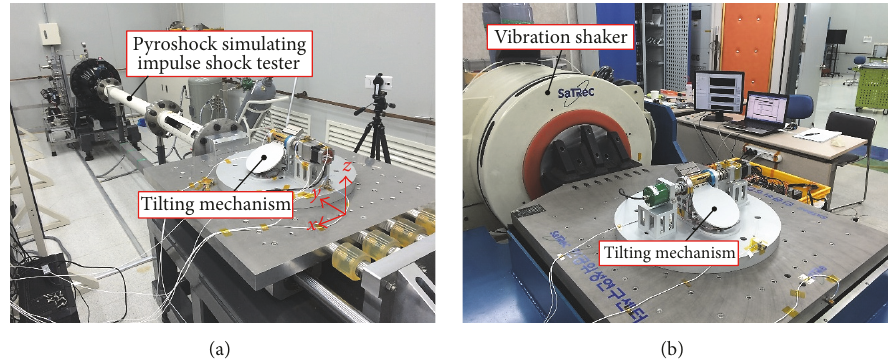
Figure 9: Launch environment test set-up ((a) pyroshock simulating impulse shock test, (b) vibration test).